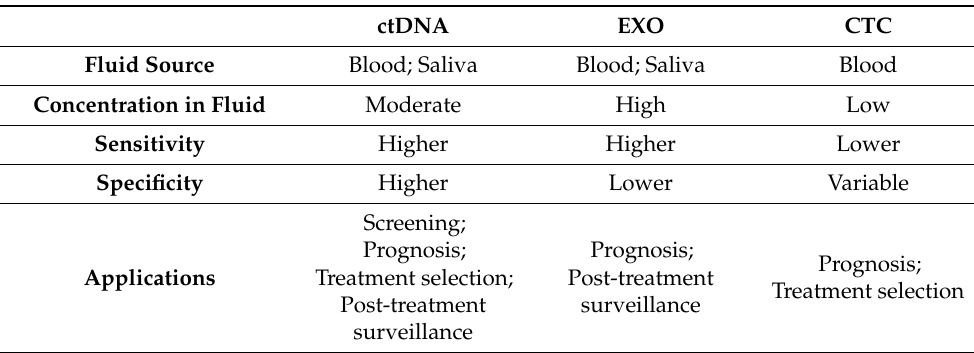
Table 3. Key characteristics of liquid biopsy targets for